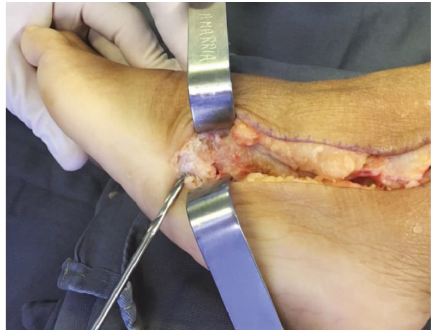
Figure 7: Patient II: the bone tunnel is drilled for a bone-to-tendon fi xation with a 3.2 mm drill at the base of the fi fth metatarsal perpendicular to the bone, from plantar to dorsal.